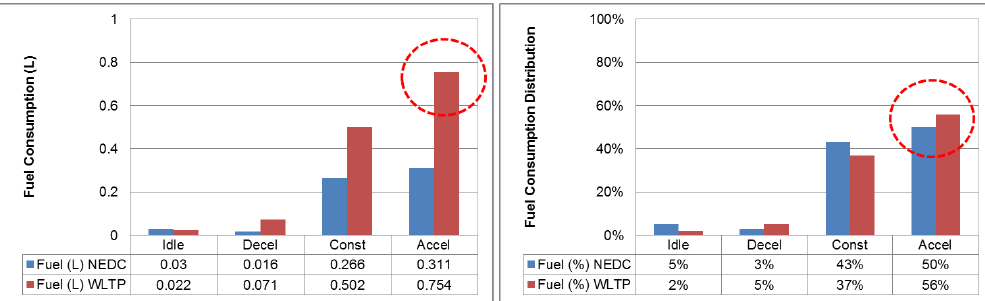
Figure 17. Effect of the test mass on the energy and fuel consumption in NEDC (left/right: gasoline/diesel) . Figure 18. Effect of the test mass on the energy and fuel consumption in WLTP (left/right: gasoline/diesel) . Test mass is the most influential factor in fuel consumption in each test cycle, and Pavlovic et al. [12] and Moon et al. [13] also showed similar trends in their simulation and test.